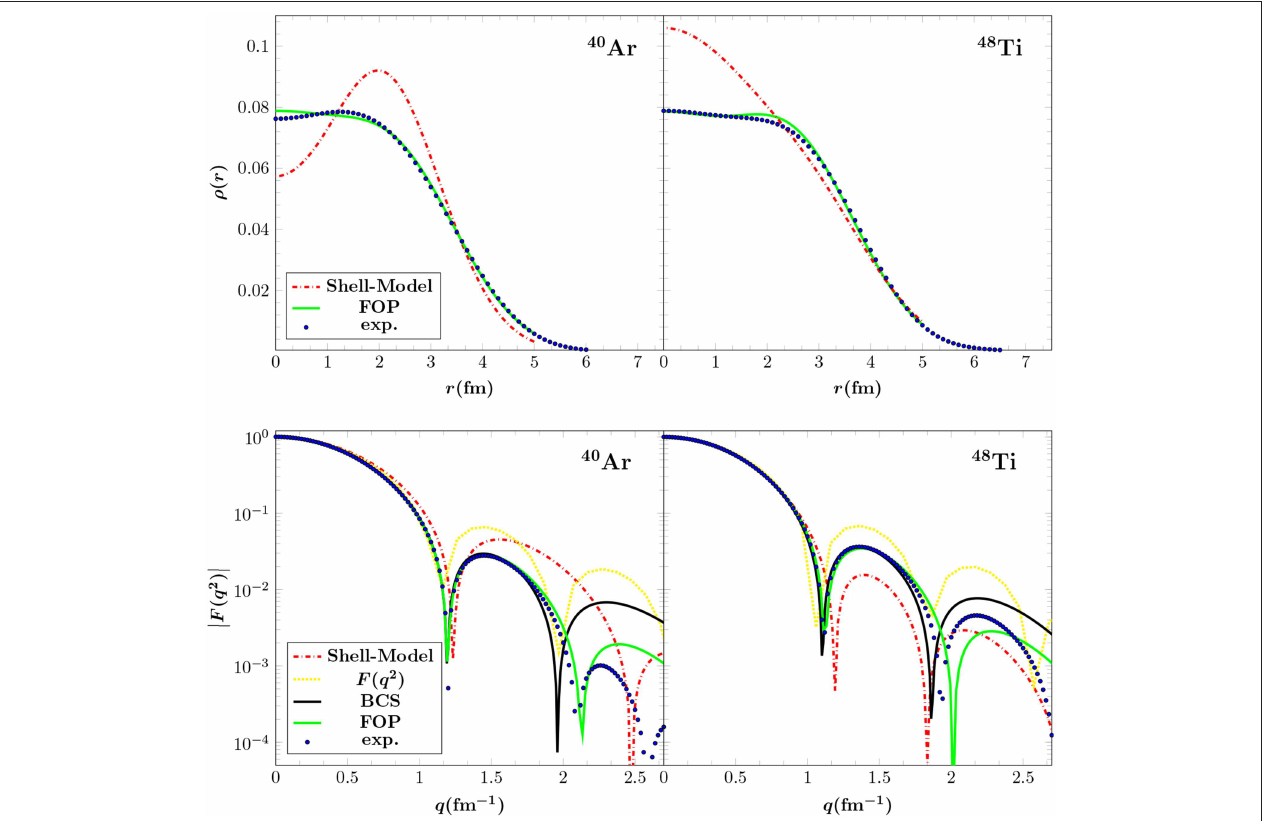
FIGURE 3 | Charge density distribution (Top) and nuclear form factor (Bottom) . The results refer to the 40 Ar and 48 Ti isotopes and are compared for different nuclear methods. Figure adapted from Papoulias and Kosmas [61] under the terms of the Creative Commons Attribution 4.0 International license.